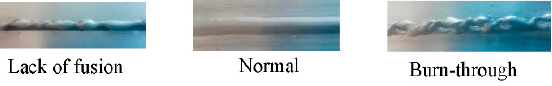
Figure 4. Weld seam states.